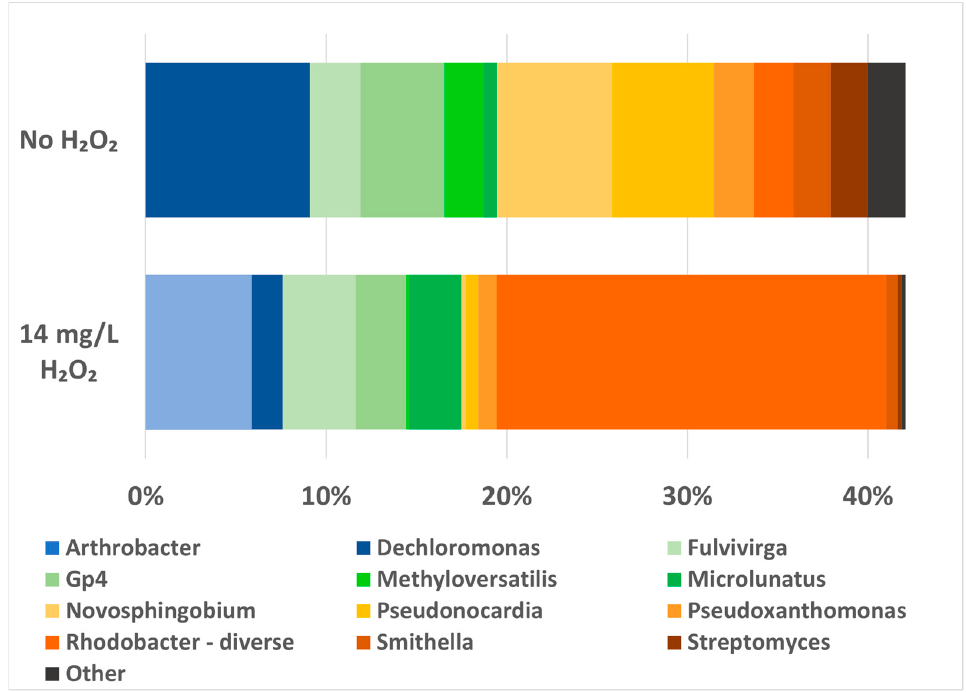
Figure 3. Comparison of the bacterial community structure (16S rRNA gene) of only the dominant genus (>2%) of the top of the two columns. genus (>2%) of the top of the two